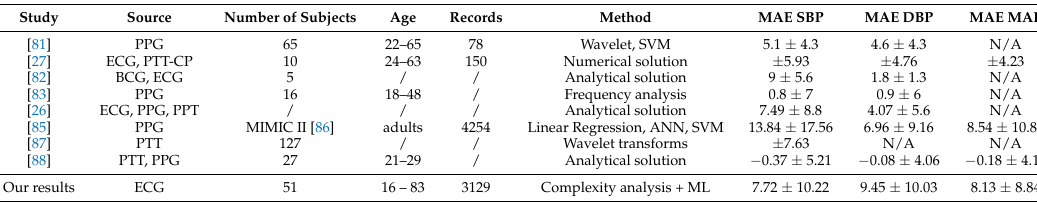
Table 11. Comparison results with prior